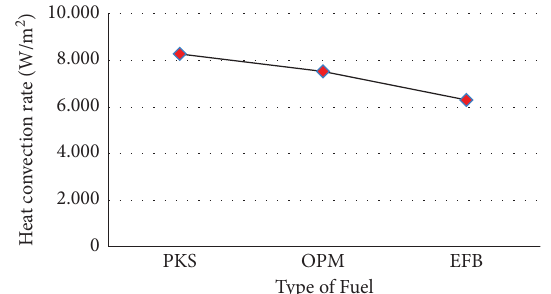
Figure 6: Heat convection rate for different fuels at the mea- surements (M-I).